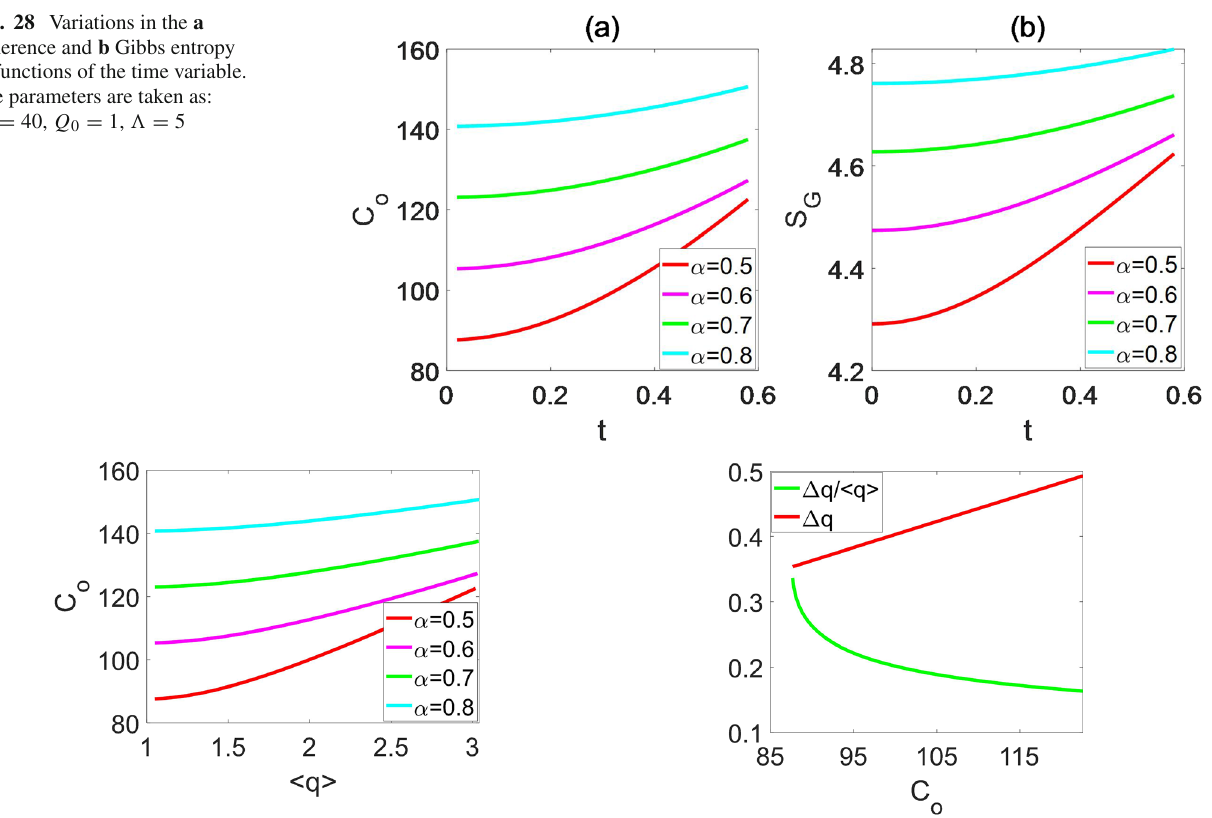
Fig. 29 Variations in the coherence versus the average value of the scale factor (cid:7) q (cid:2) . The parameters are taken as: V 0 = 40, Q 0 = 1, (cid:18) = 5